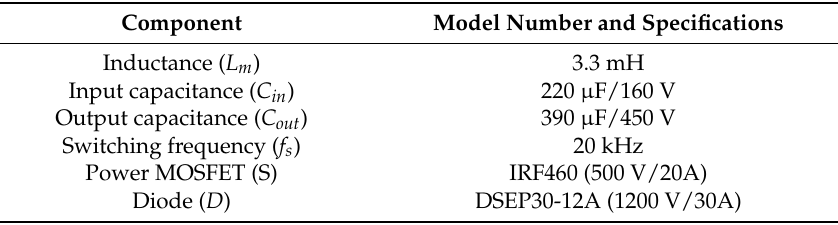
Figure 6. Architecture of the I-TLBO-based MPPT controller. Table 2. DC/DC boost converter component parameters.